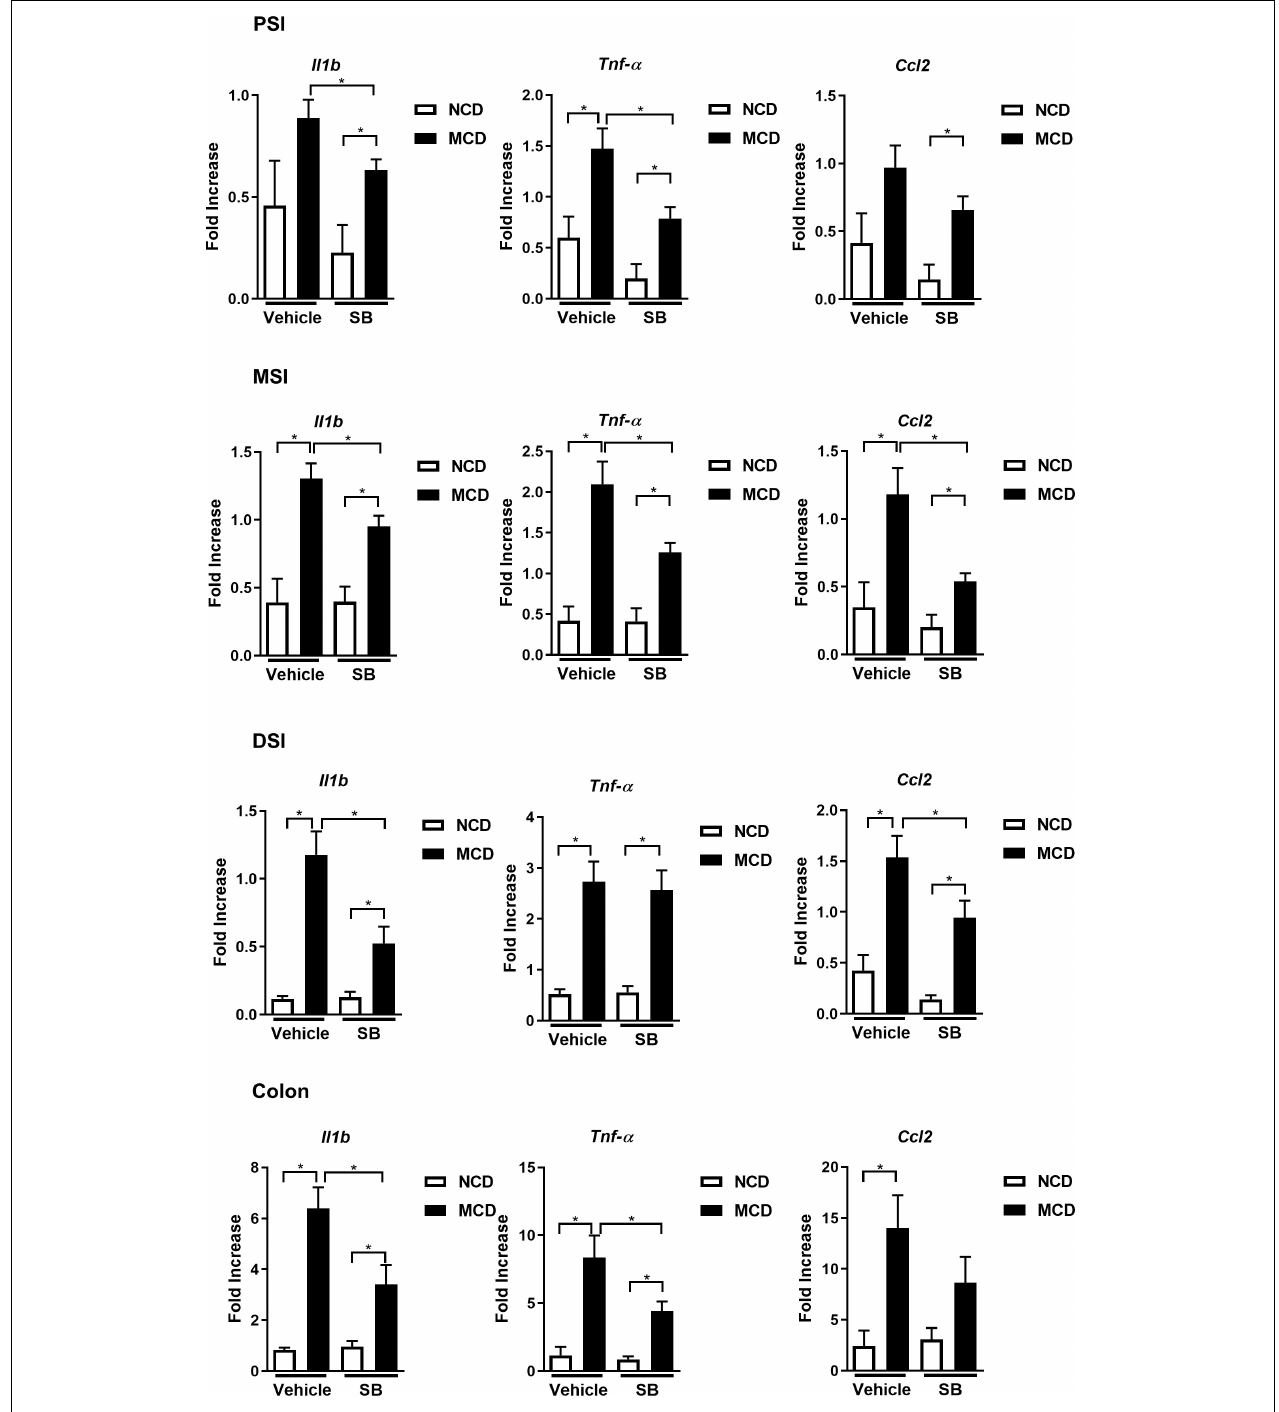
FIGURE 5 | SB ameliorated the MCD diet-caused intestinal inflammation. Intestinal expression of proinflammatory cytokines Il1b, Tnf- α , and CCL2 in the proximal, middle, distal small intestine (PSI, MSI, and DSI), and colon. * p < 0.05.